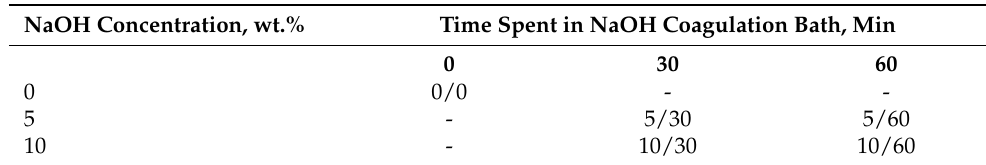
Table 1. The casting parameters’ combinations and assigned membrane codes (0/0 for the membrane only coagulated in water). NaOH Concentration, wt.% Time Spent in NaOH Coagulation Bath, Min 0 30 60 0 0/0 - - - 5/30 5/60 - 10/30 10/60